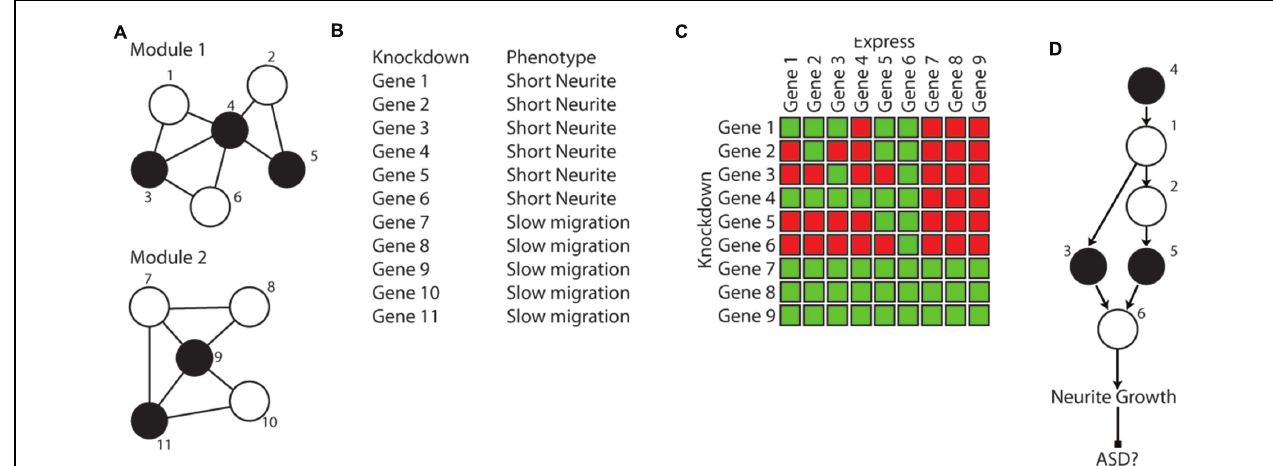
FIGURE 3 | Hypothetical example of phenotypical clustering and epistasis analysis in a culture model. (A) A hypothetical network constructed with five ASD genes (black) has resulted in two modules of 5–6 genes that are connected by expression and PPI data that include both ASD genes and tightly connected genes (white) not yet implicated in ASD. (B) The network result leads to a hypothesis that genes that are in the same module regulate the same phenotype. This is tested using single gene knockdown in iPSC derived neurons followed by high content imaging of neuronal morphology and behavior. Knockdown of the members of the two modules results in distinct cellular phenotypes, consistent with them potentially representing two distinct mechanisms of developing ASD (potentially two subtypes requiring different treatments). In this hypothetical example the tightly connected genes show the same phenotype. (C) Epistasis analysis for neurite length is used to test the hypothesis that all genes in module 1 are in the same pathway regulating neurite growth and are distinct from genes in module 2. Single gene knockdowns of all genes are transiently transfected with constructs expressing each individual gene. Green squares are normal neurite length, red squares are shortened neurites. These hypothetical results suggest several conclusions: (1) negative control genes from module 2 can’t rescue short neurites, again indicating they are not in this genetic pathway. (2) As a control, expression of each gene in module 1 can rescue (complement) its own phenotype. (3) The pattern of complementation can be used to infer the functional relationship between the genes (D) . For example, gene 4 can be rescued by any other gene in the module, suggesting it must be before the others in the pathway, while gene 6 can rescue all others, but cannot be rescued by any of them, indicating it must be last. (D) The resulting pathway from the genetic analysis of neurite length. This result indicates that the original module did indeed represent a set of genes that regulate the same neurobiological phenomena. If indeed the shortened neurites lead to ASD, this also suggests that treatments targeting gene 6 (even though it was not itself an ASD gene), may be effective at treating individuals with ASD who have mutations in genes 3, 4, or